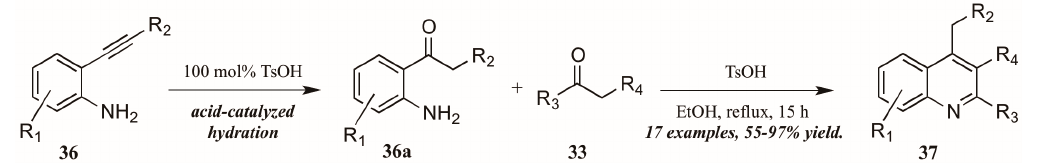
Figure 17. Brønsted acid-mediated Friedländer reaction starting from 2-alkynylanilines.